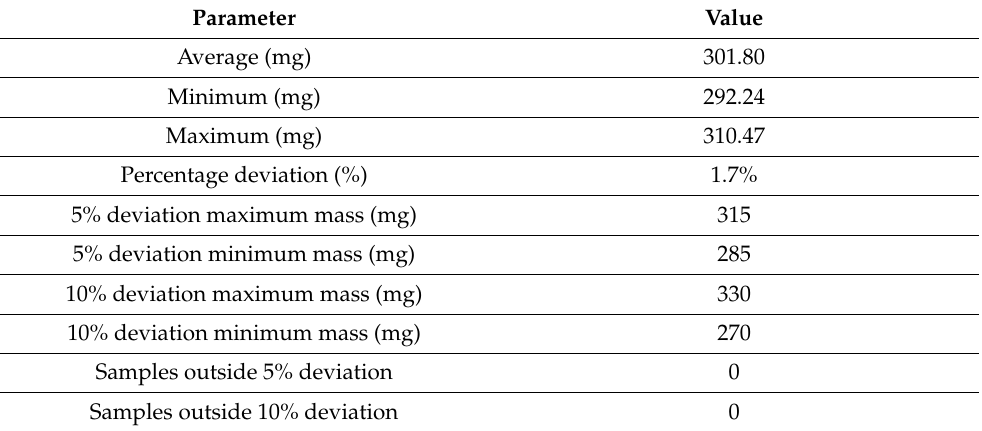
Table 14. Mass, mass relative standard deviation (RSD) and number of samples falling outside pharmacopeia standards based on mass uniformity results of oral form masses printed from 113.7 mm of the